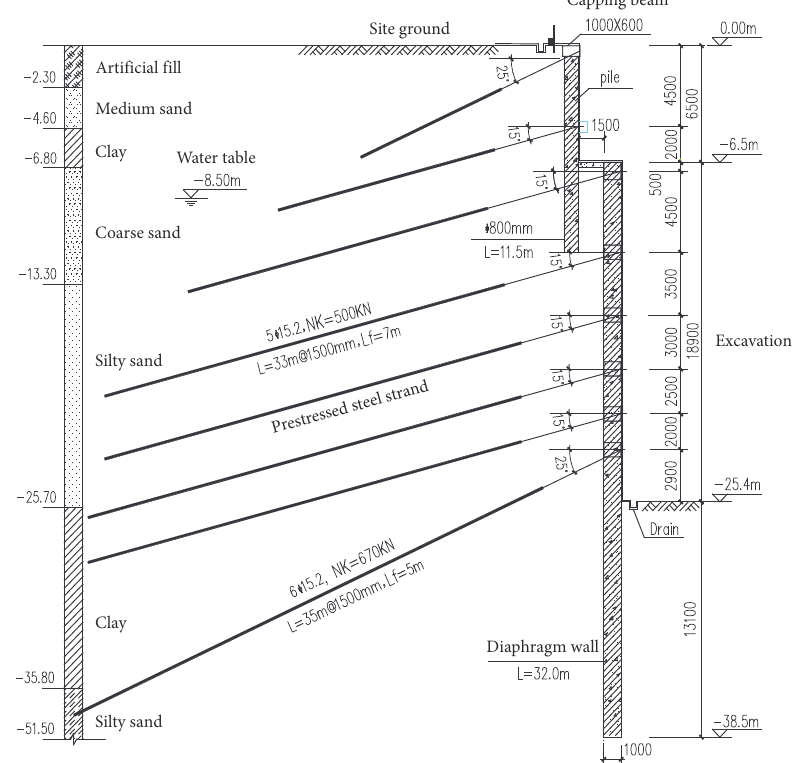
Figure 3. Longitudinal section of the composite retaining and protection structure at the south side of the excavation